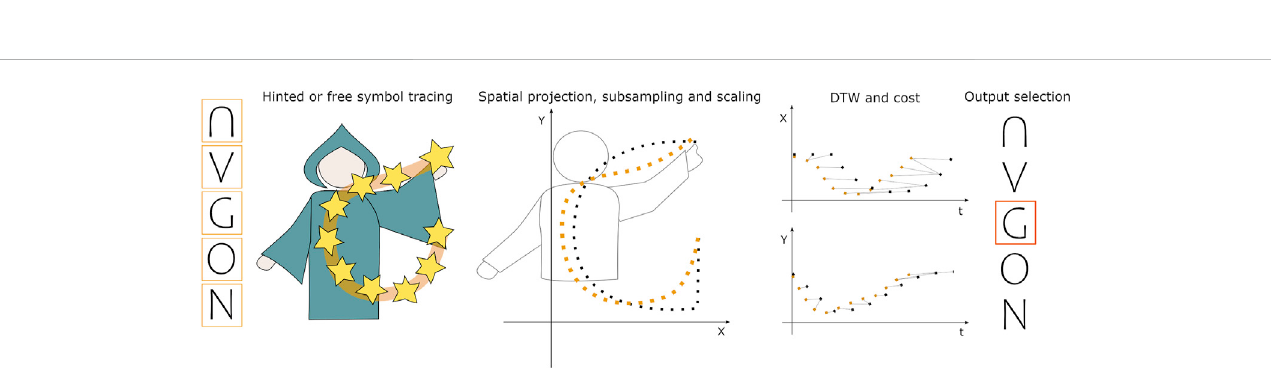
FIGURE 2 Symbol drawing exercise and structure of data processing: it supports both hinted and free spell tracing, allowing for introduction of cognitive elements in the